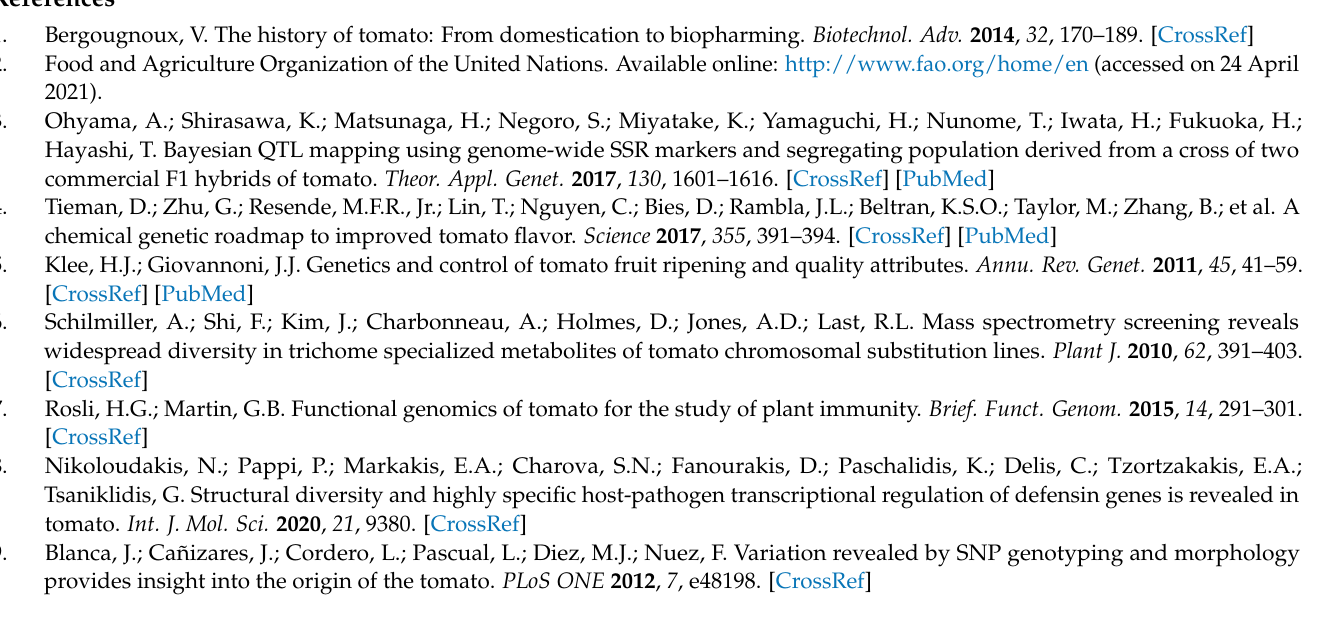
(B). Figure S2: Correlation and hierarchical clustering of agro-morphological traits as established for quantitative traits. Figure S3: Levels of attributes explaining variation across Cypriot tomato landraces. Figure S4: Single run electropherogram setup depicting the concurrent analysis of the ten loci employed. Figure S5: Genotype accumulation curve for Cypriot accessions. Proportion of MLGs identified based on the number sampled loci and 1000 randomizations. Figure S6: Estimates of genotypes differentiation based on population diversity indexes. Figure S7: Probability of Hardy Weinberg disequilibrium for the loci studied depicted as a heatmap. Table S1: IPGRI descriptors. Table S2: Primers used. Table S3: Morphological characters. Table S4: F st